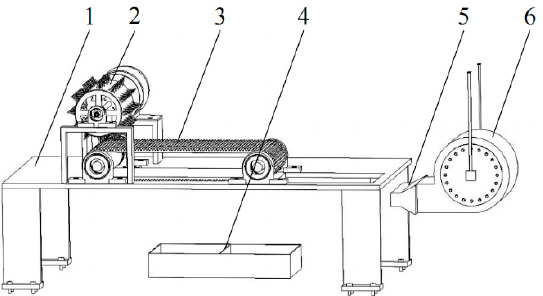
Figure 1. The structure diagram of the threshing and clearing process on the seed testing